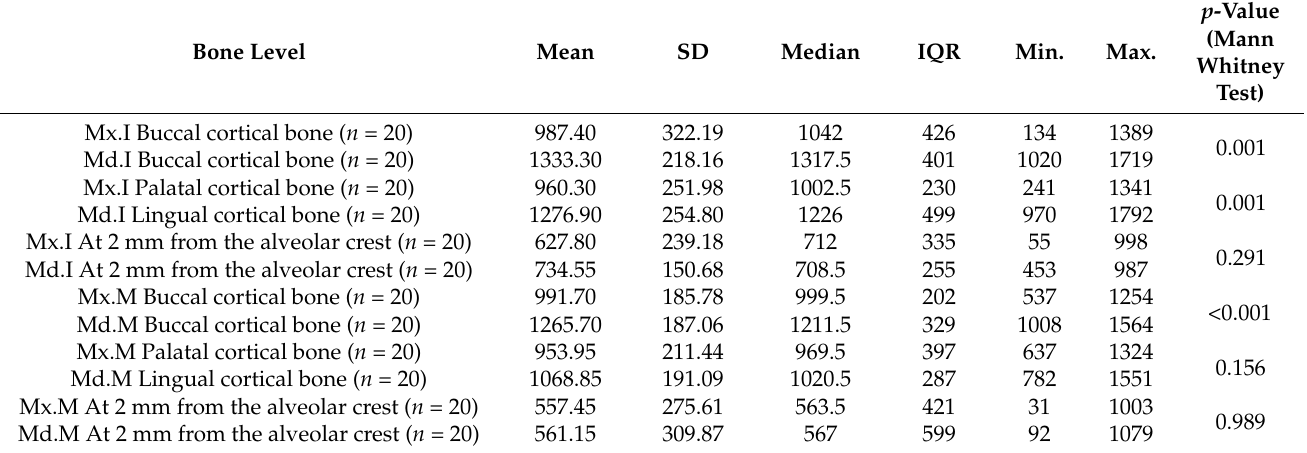
Table 2. HU values assessment in the trabecular bone at the external buccal and palatal/lingual internal cortical bone level and at a depth of 2 mm from the alveolar crest, as well as the difference between the maxillary central incisors and the first molars and the mandibular central incisors and the first molars.